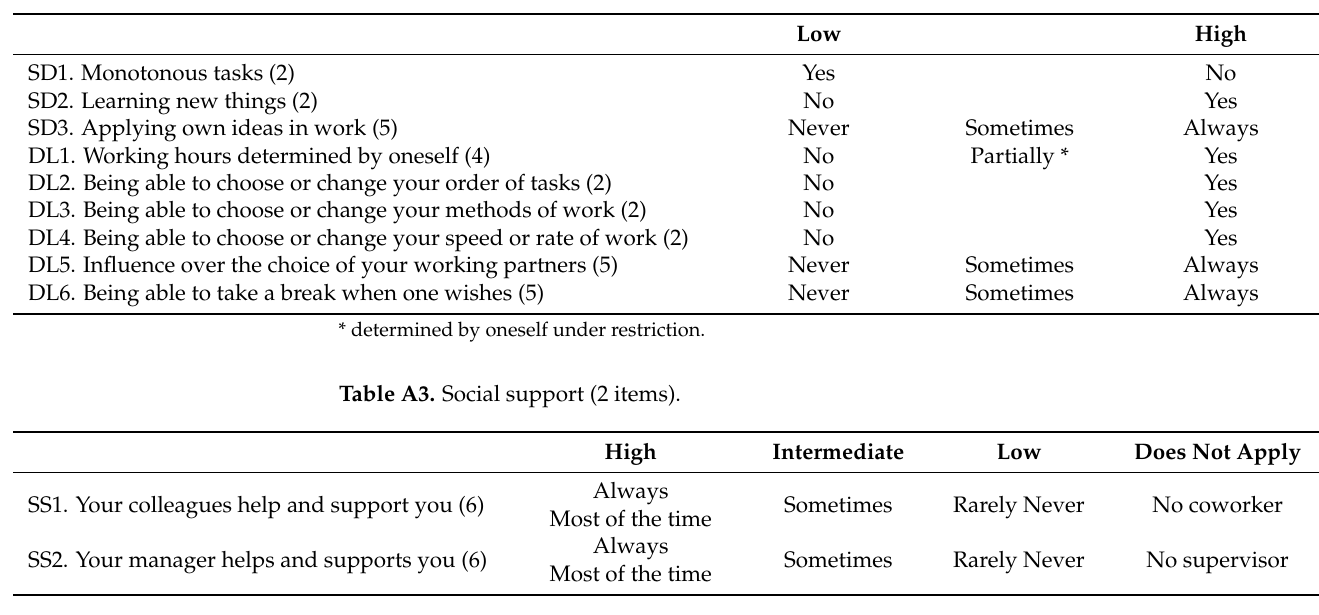
Table A2. Decision latitude (9 items).